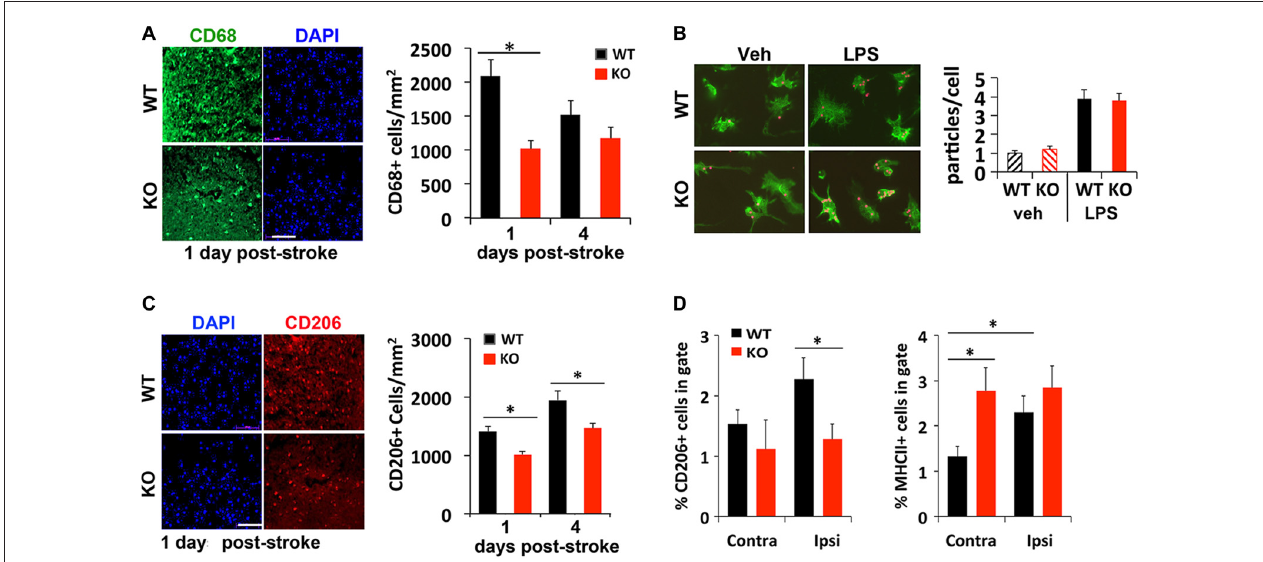
FIGURE 3 | Reduced recruitment of M2 microglia/macrophages in IRF2BP2KO mice after stroke. (A) Fewer CD68+ cells, a marker for microglia/macrophages, in the peri-infarct area of IRF2BP2KO mice compared to their littermate controls (WT). N = 6 mice/group. (B) Microglia from IRF2BP2KO mice engulf similar numbers of red microparticles as littermate controls, with or without LPS stimulation (100 ng/ml, 24 h). N = 3 mice/group. (C) Fewer anti-inflammatory M2 (CD206+) microglia in the peri-infarct area of KO mice. N = 6 mice/group. Scale bar, 100 µ m. (D) FACS analysis of CD206+ (M2) and MHCII+ (M1) microglia isolated from contralateral and ipsilateral cortex 4 days after stroke. Sham, sham operated mice. N = 4 mice/group. ∗ p < 0.05.